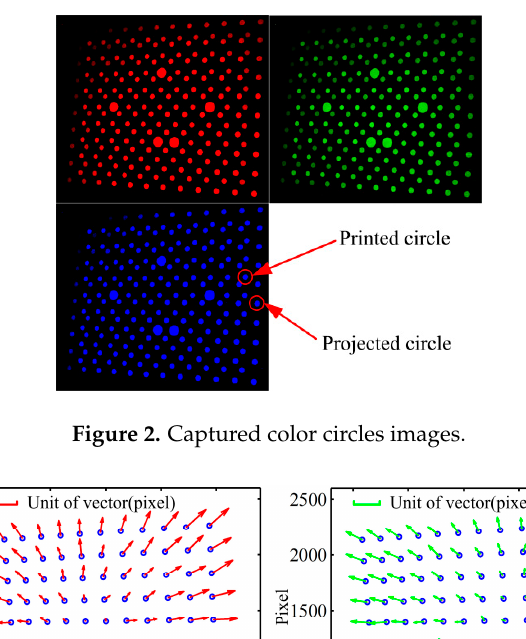
Figure 1. Lateral chromatic aberration (LCA) in structured light system.